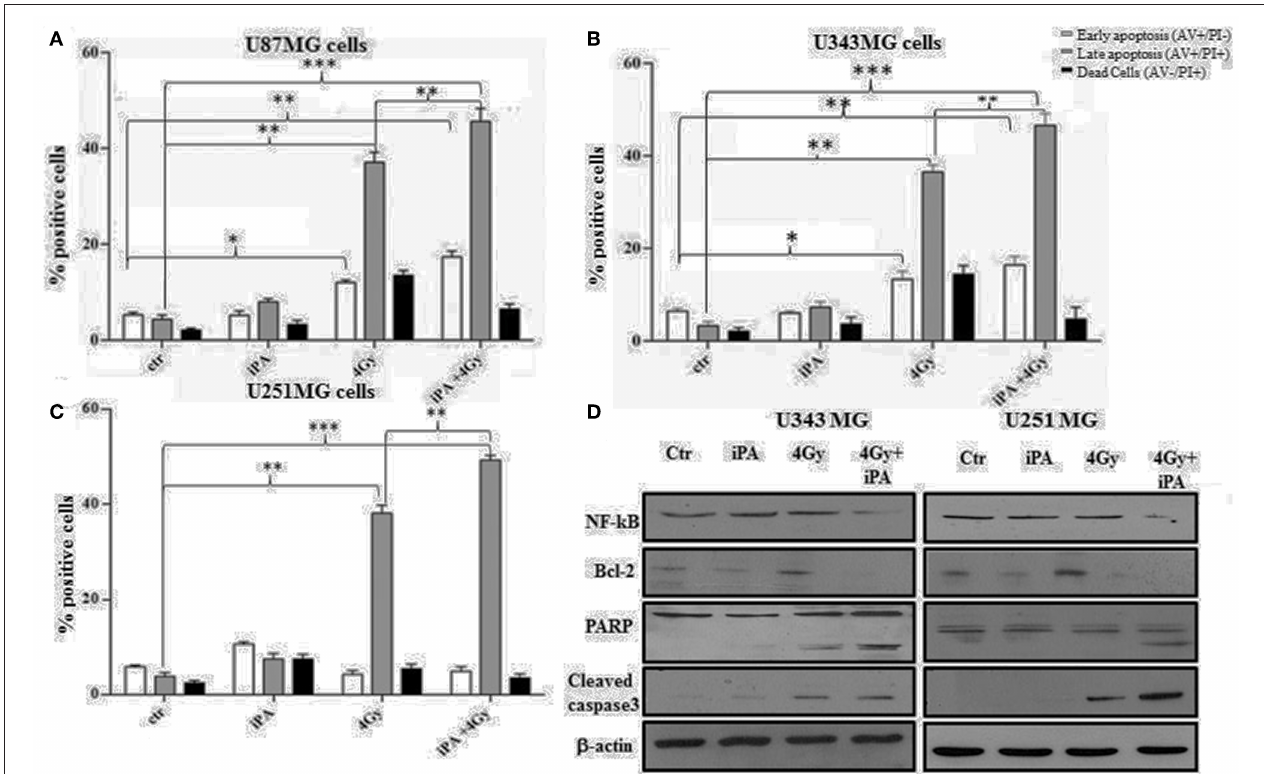
FIGURE 2 | Effect of iPA in combination with IR on integrity of human glioblastoma cells. (A–C) Flow cytometric analysis of Annexin V and propidium iodide (PI) double staining in glioblastoma cells. Histograms show the total percentage of early (Annexin V-positive cells/PI-negative cells) and late apoptotic events (Annexin V/PI-double positive cells) as well as necrotic cells (Annexin V-negative cells/PI-positive cells). Results are representative of five experiments performed in duplicate and expressed as mean ± SD (ANOVA * p < 0.05, ** p < 0.01, *** p < 0.001). (D) Expression of typical apoptosis markers, cleaved caspase-3, cleaved PARP, Bcl2, and NF-kB based on western blotting. β -actin was used as loading